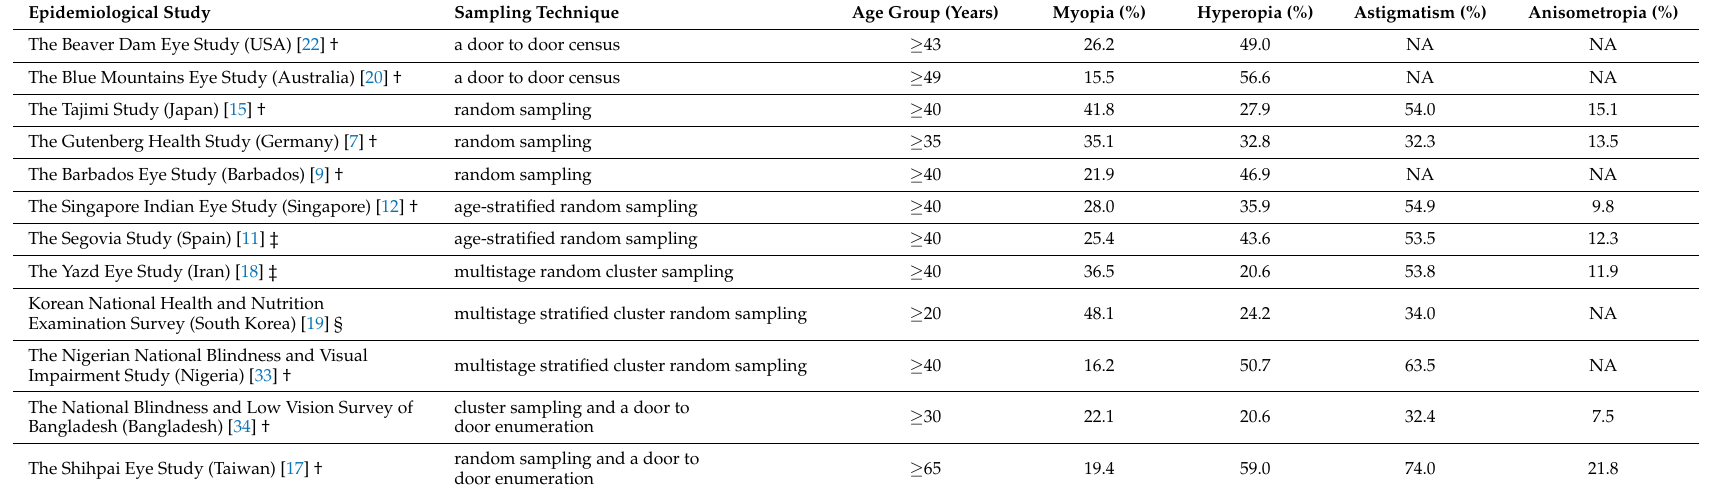
Table 4. Comparison of sampling techniques and the prevalence rates of refractive errors in different populations from previously published studies. Epidemiological